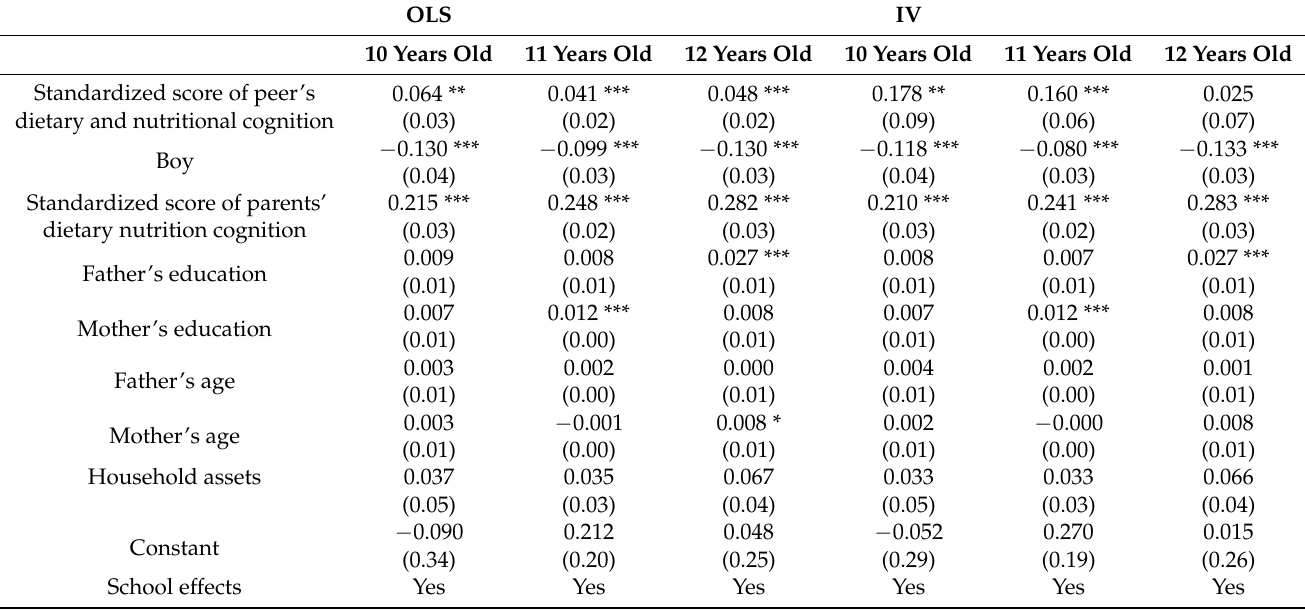
Table 7. Peer effect on the cognition of diet and nutrition for students with different